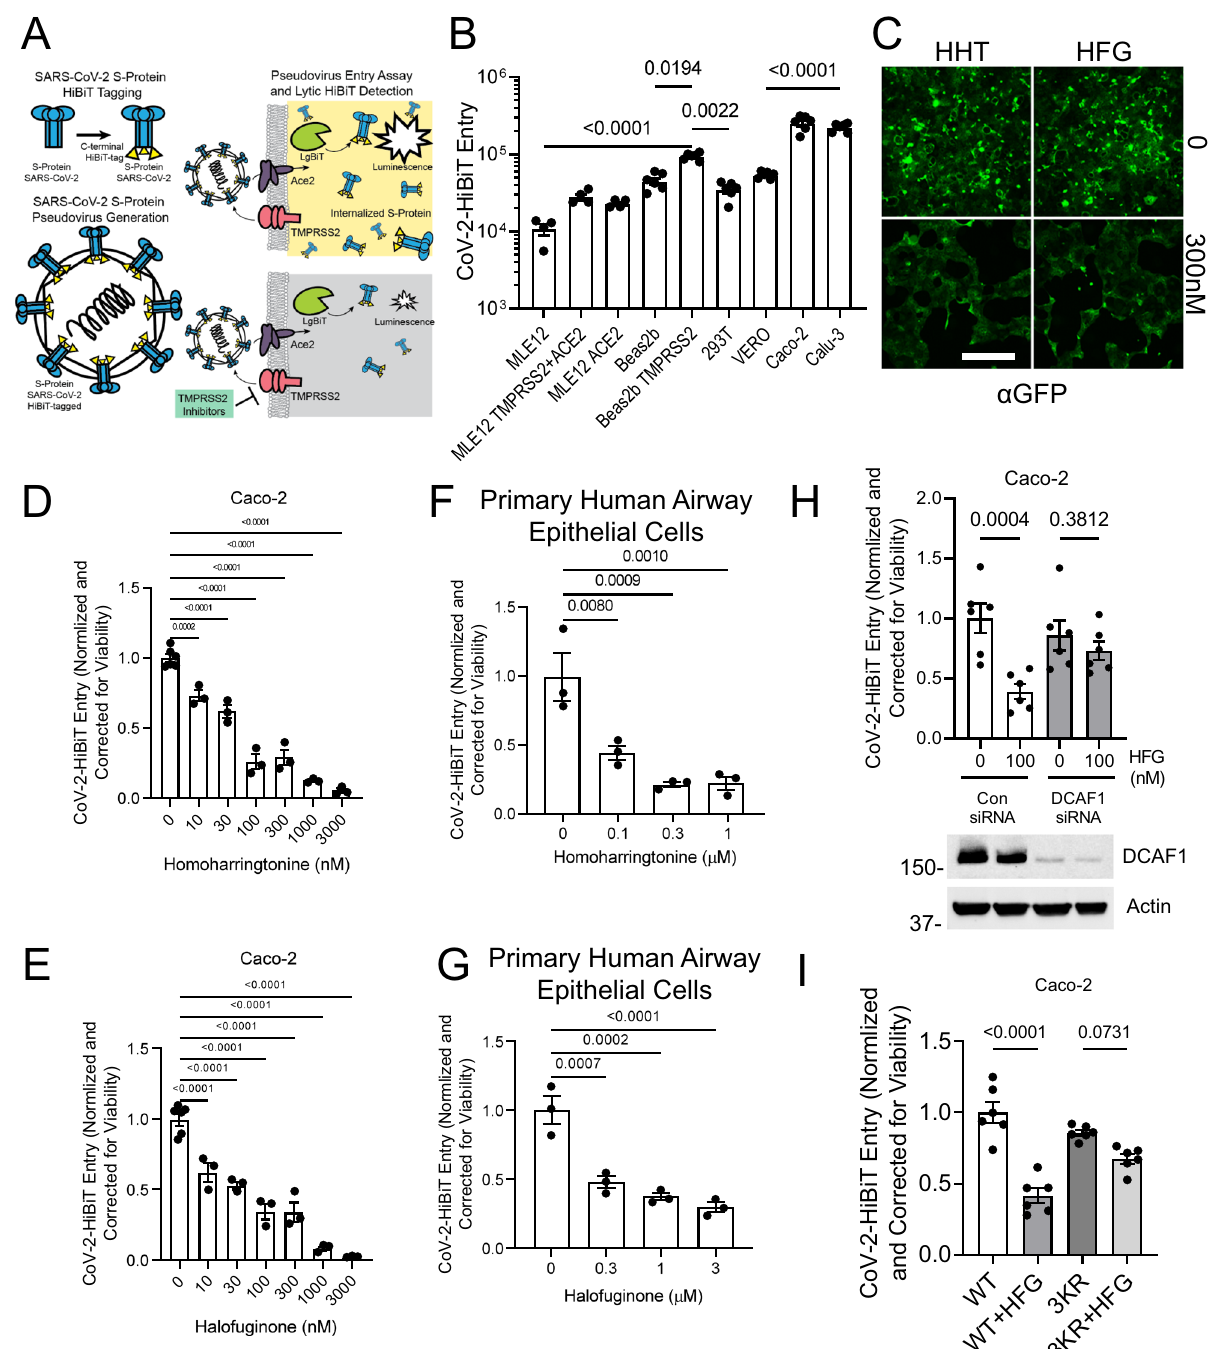
Fig. 7 Agents that reduce TMPRSS2 expression markedly inhibit SARS-CoV-2 pseudoviral infection. A Schematic of pseudoviral construction and assay. The S protein of SARS-CoV-2 was C-terminally tagged with HiBiT. B Level of viral transduction in various cell lines plotted on a logarithmic scale. Calu-3 and Caco-2 cells had the highest observed rates of infection. Data are mean ± SEM ( n = 4 – 6 biologically independent samples). C Effects of HHT or HFG on pseudoviral-mediated GFP expression, determined by immunostaining, scale bar = 500 µ m. D , E Effects of increasing concentrations of homoharringtonine (HHT) ( D ) or halofuginone (HFG) ( E ) on SARS-CoV-2 pseudoviral infection. Data are mean ± SEM ( n = 3 – 6 biologically independent samples). F , G SARS- CoV-2 pseudoviral infection of primary human bronchial epithelial cells in the presence of increasing concentrations of HHT ( F ) and HFG ( G ). Data are mean ± SEM ( n = 3 biologically independent samples). H SARS-CoV-2 pseudoviral infection of Caco-2 cells transfected with DCAF1 siRNA along with HFG treatment (100 nM). Data are mean ± SEM ( n = 6 biologically independent samples). I SARS-CoV-2 pseudoviral infection of Caco-2 cells transfected with TMPRSS2 WT or lysine mutant prior to HFG treatment (100 nM). All SARS-CoV-2 pseudoviral data is corrected to cell number as determined by CellTiter- Glo. Data are mean ± SEM ( n = 6 biologically independent samples). P -values are shown for comparisons to 0 time point or control, or as indicated by